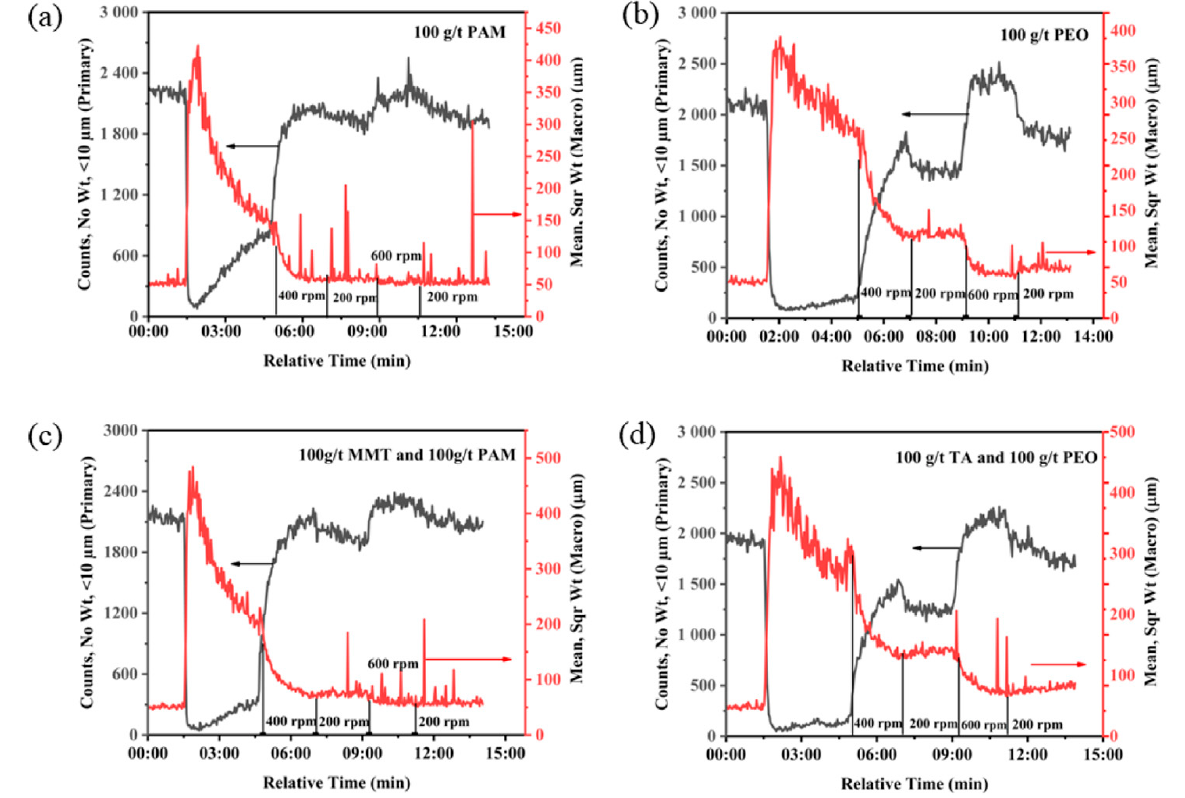
Figure 9. The trend of Mean Particle Size (MPS) (square weighted, macro mode) and Counts of Fine Particles (CFP) ( ≤ 10 μ m, no weighted, primary mode) as a function of stirring time: initially 200 rpm and accelerated afterwards: ( a ) PAM; ( b ) PEO; ( c ) PAM-MMT; ( d ) PEO-TA.